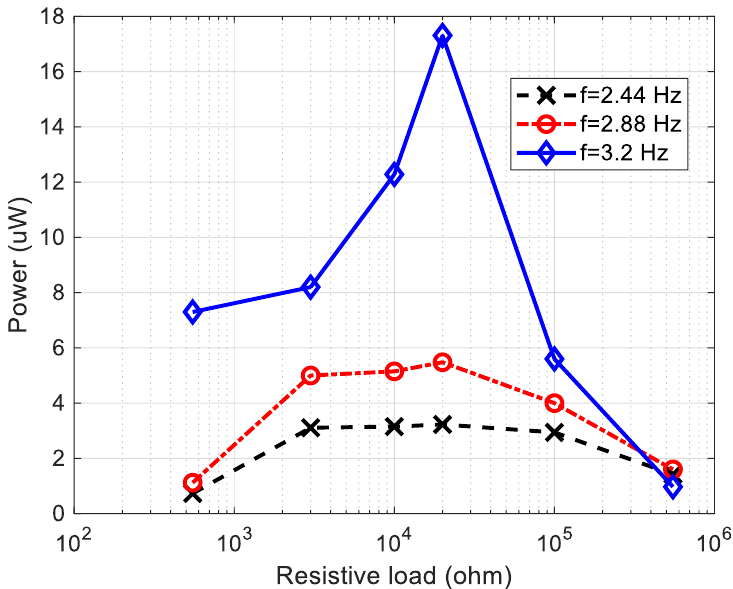
Figure 12. Generated power versus external resistance load for different motion frequencies; C in = 22 µ F; and C out = 47 µ F. Table 2. Comparison of the output power of similar piezoelectric